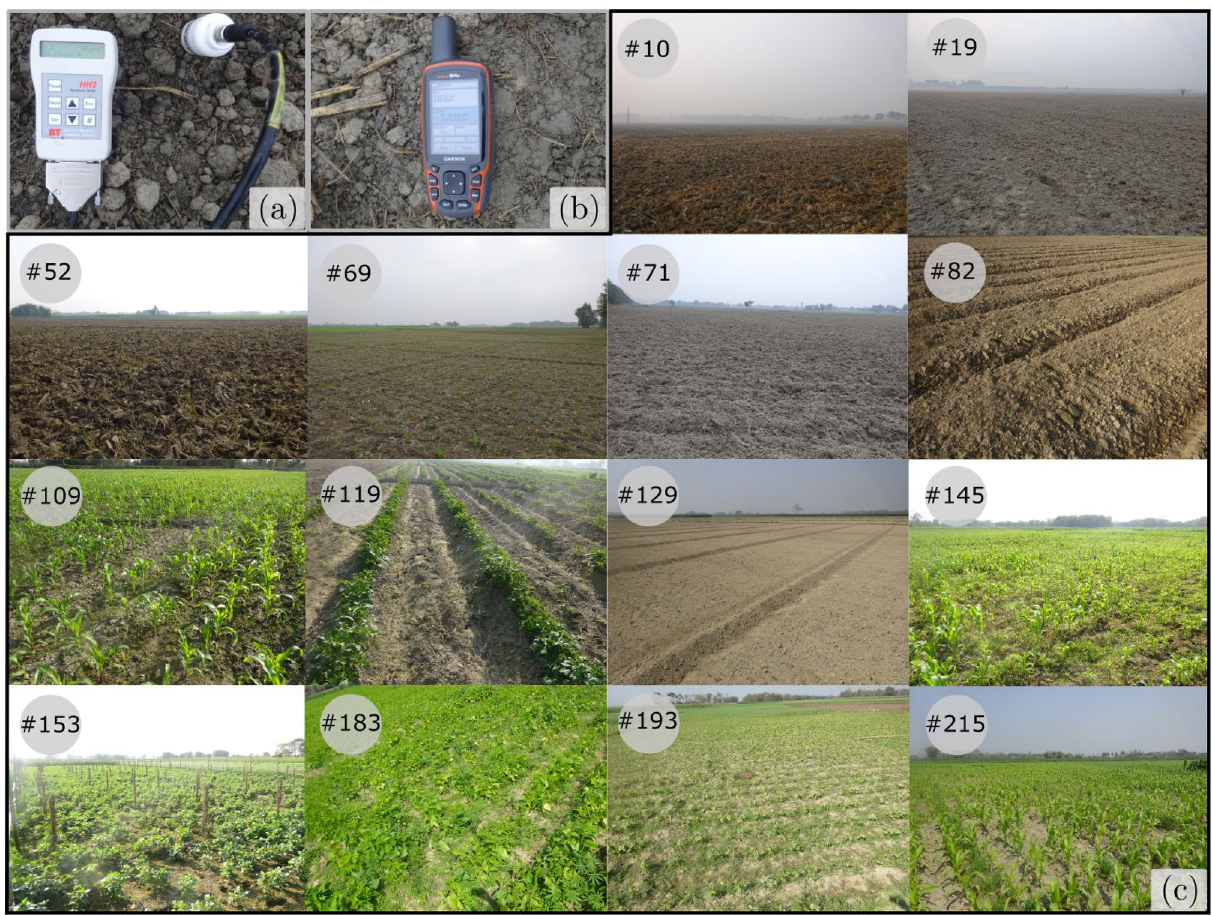
Figure 3. Field photographs illustrate the ground conditions (#10, #19, #52, #69, #71, #82, #109, #119, #129, #145, #153, #183, #193, #215) of the study area at the time of soil-moisture measurement